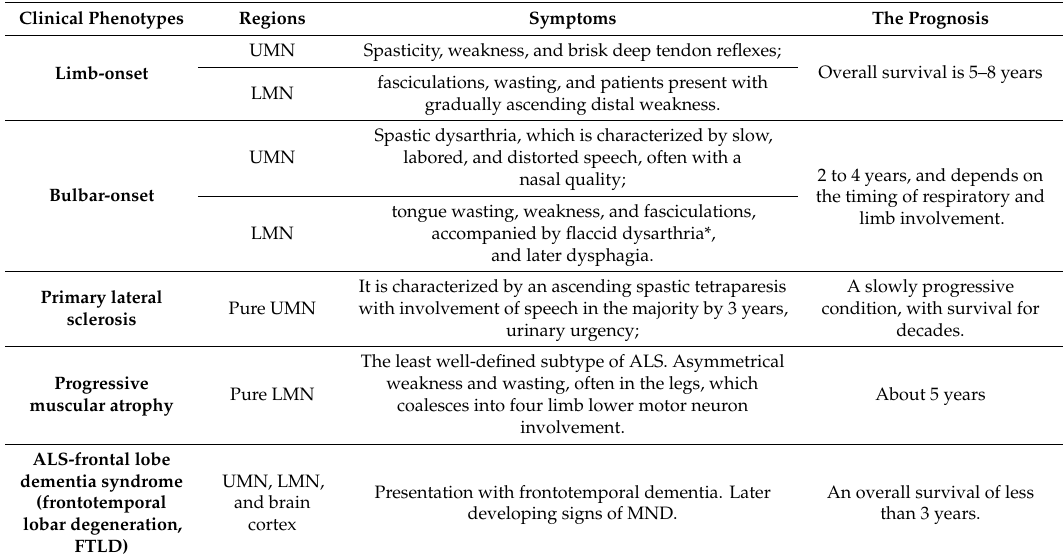
Table 1. Clinical phenotypes, symptoms, and prognosis of amyotrophic lateral sclerosis (ALS). Clinical